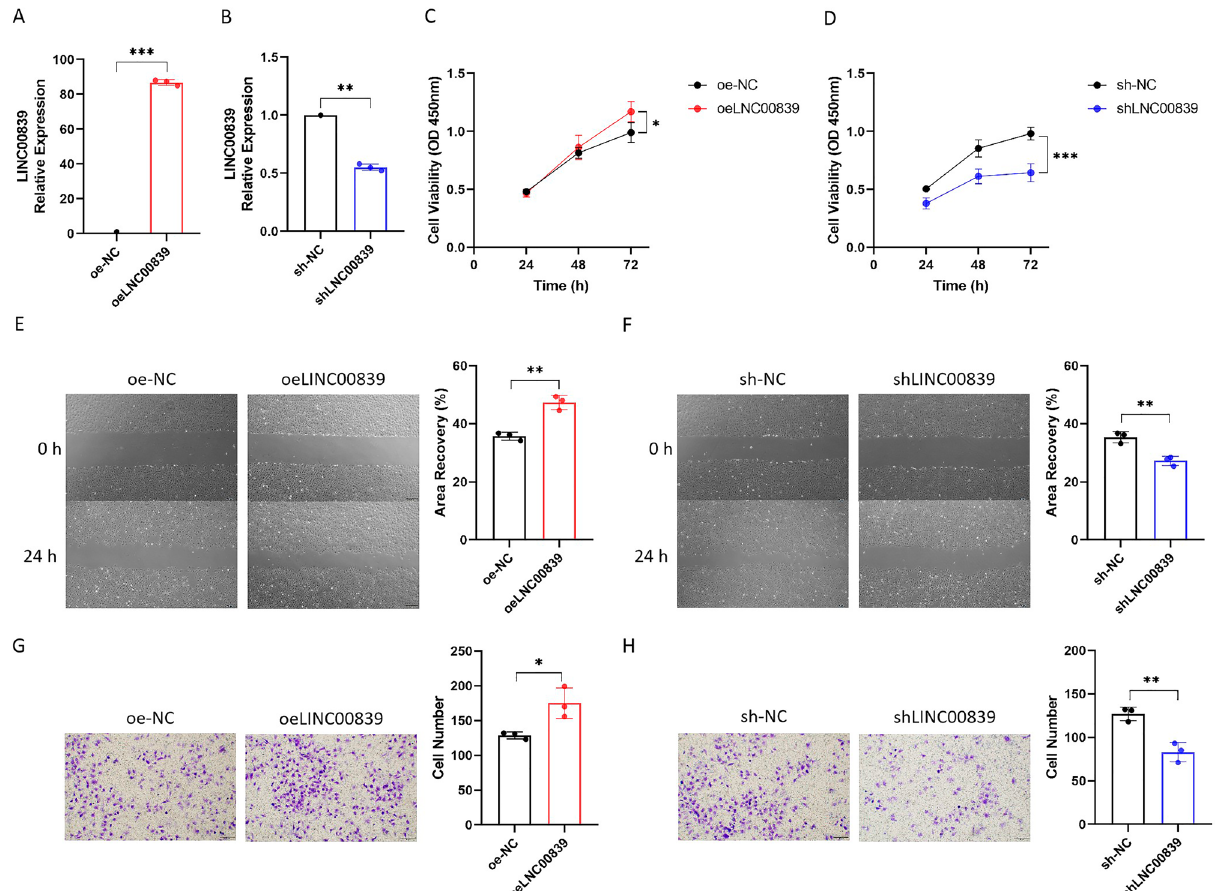
Figure 3. LINC00839 facilitates liver cancer cell proliferation, migration, and invasion under hypoxia. ( A ) The relative expression of LINC00839 in liver cancer cells after infected with LINC00839-overexpressing lentivirus (oeLINC00839) and overexpressing NC lentivirus (oe-NC) under hypoxia. ( B ) The relative expression of LINC00839 in liver cancer cells after infected with LINC00839 shRNA lentivirus (shLINC00839) and shRNA NC lentivirus (sh-NC) under hypoxia. ( C , E , G ) The proliferation, migration, and invasion ability in the oeLINC00839 group and oe-NC group under hypoxia. ( D , F , H ) The proliferation, migration, and invasion ability in the shLINC00839 group and sh-NC group under hypoxia. The red bar represented oeLINC00839 group, the blue bar represented shLINC00839 group, and the black bar represented oe-NC and sh-NC group. The experimental data was represented by mean ± SD from at least three independent experiments. * P < 0.05, ** P < 0.01, *** P <